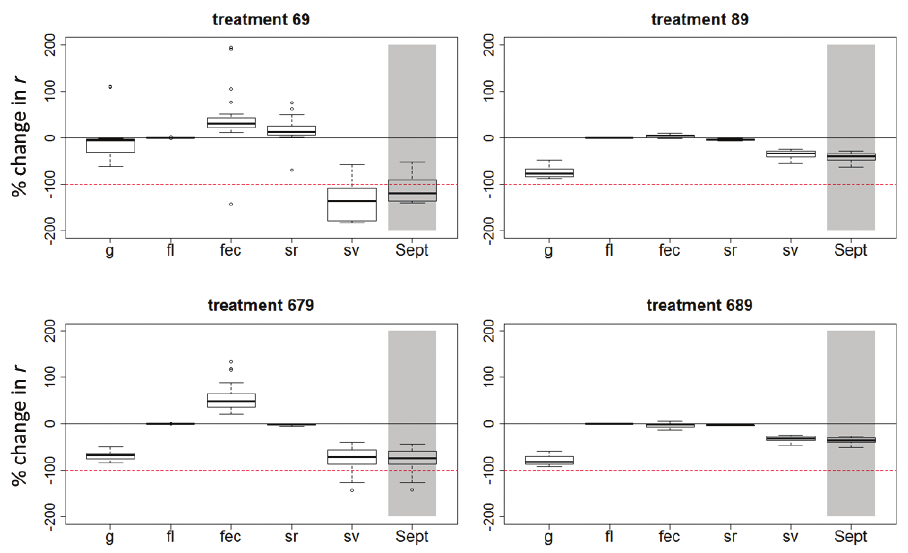
Figure 4. The influence of single vital rates and the September cut on population growth. Figures show the relative contributions of each vital rate (g = growth, fl = flowering, fec = fecundity, sr = seed ripening, sv = seed viability, see Fig. 1) and the cut in September (Sept, i.e. combined effect of sr and sv) to the total change in the population growth r per treatment. The y-axis represents the percentage change in r com- pared to the untreated reference, relative to the total change due to the mowing treatment (red dashed line at -100%). Boxplots indicate variation across reference data sets (N = 6) and years (N = 5, if